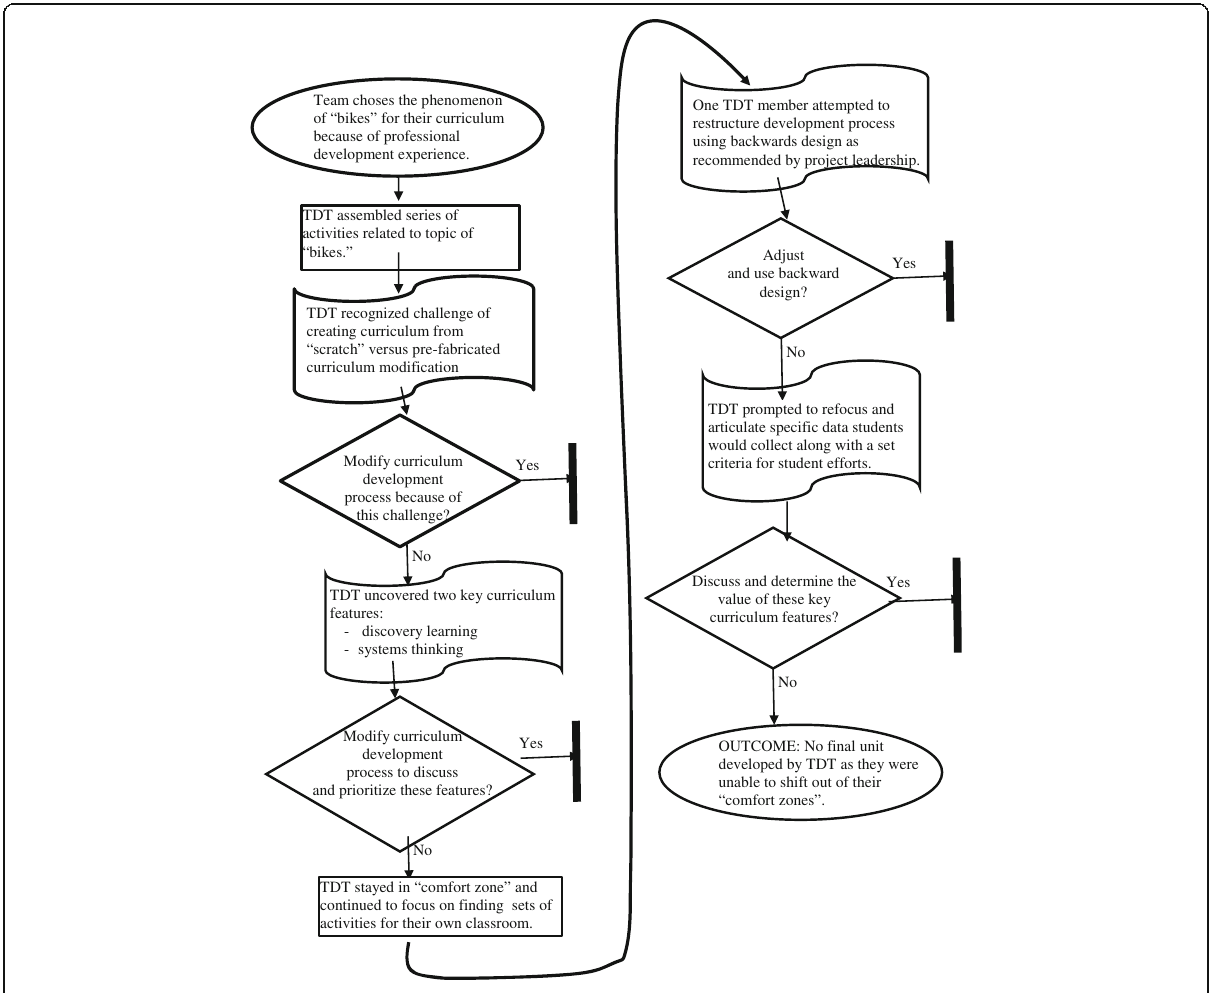
Fig. 1 Map of team Reckoning Force ’ s approach to curriculum unit